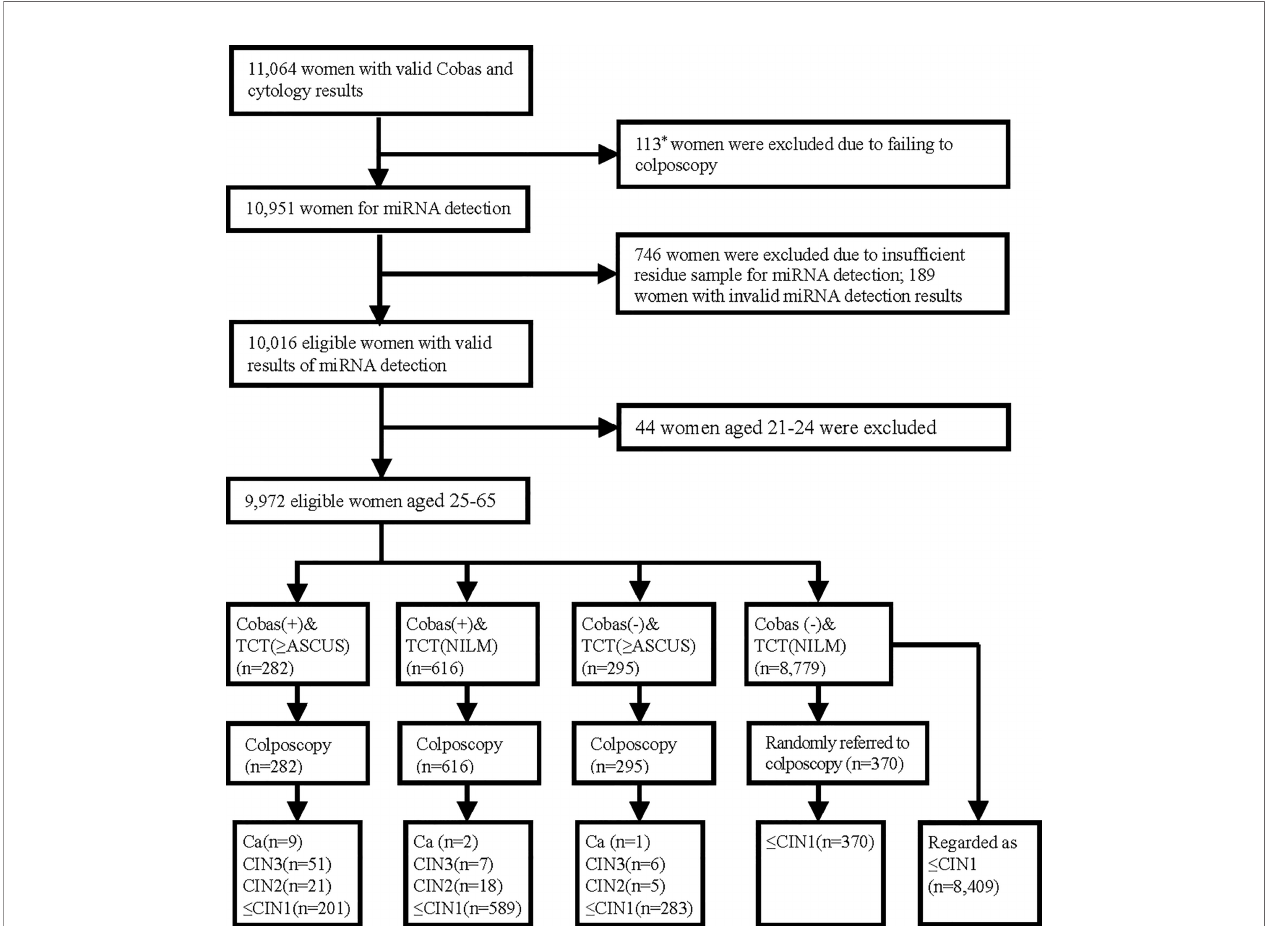
FIGURE 1 | Test results and outcomes. *Included 86 women who had abnormal Cobas HPV/cytology results but failed to have colposcopy and 27 women with normal Cobas HPV and cytology results who were randomly selected for colposcopy but did not undergo